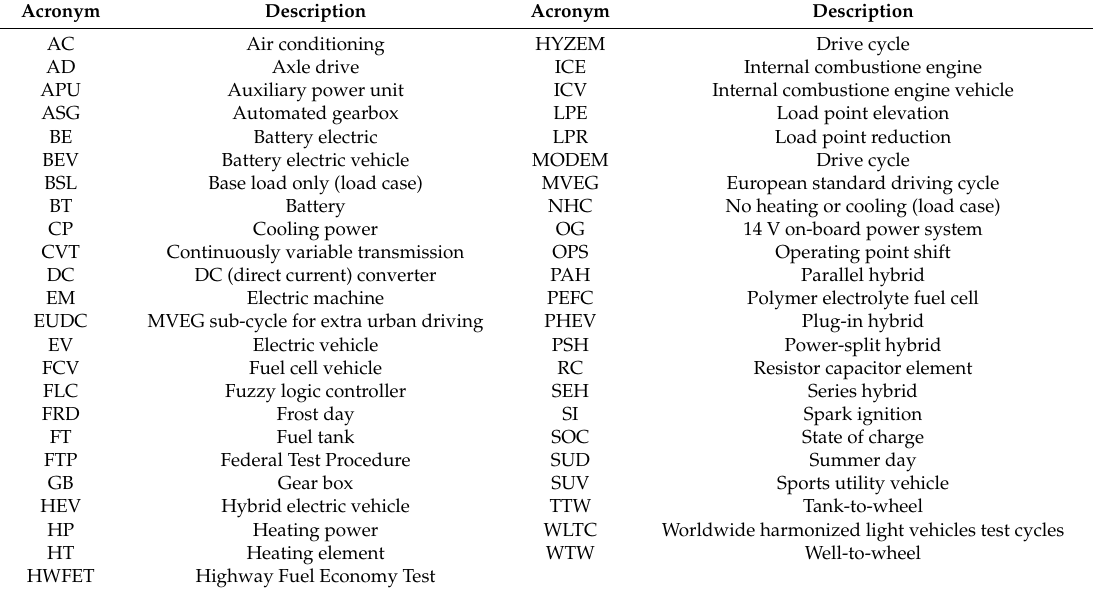
Table A1. Acronyms. Table A1. Acronyms.